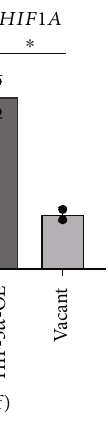
Figure 2: HIF-3 α overexpression globally regulates gene expression in HeLa cells. (a) Sample correlation results showed a clear separation between HIF-3 α OE and vacant samples. (b) Volcano plot showed the DEG results of HIF-3 α OE and vacant samples. (c) Hierarchical clustering heat map showed the dominant upregulated genes after HIF-3 α OE. (d) Top functionally enriched GO BP terms and KEGG pathways for HIF-3 α upregulated genes. (e) Heat map showed the upregulated genes by HIF-3 α OE. (f) Bar plot showed the expression levels of HIF1A transcripts upon HIF3A overexpression and